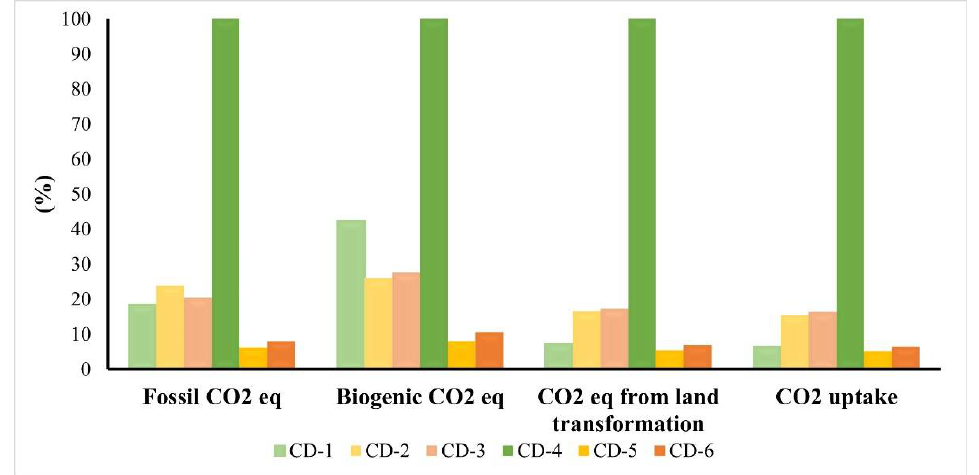
Figure 5. Relative environmental impacts of syntheses under study, applying Greenhouse Gas Protocol method. Green scale refers to hydrothermal treatments; Yellow scale refers to microwave-assisted treatments; Orange scale refers to calcination treatments.